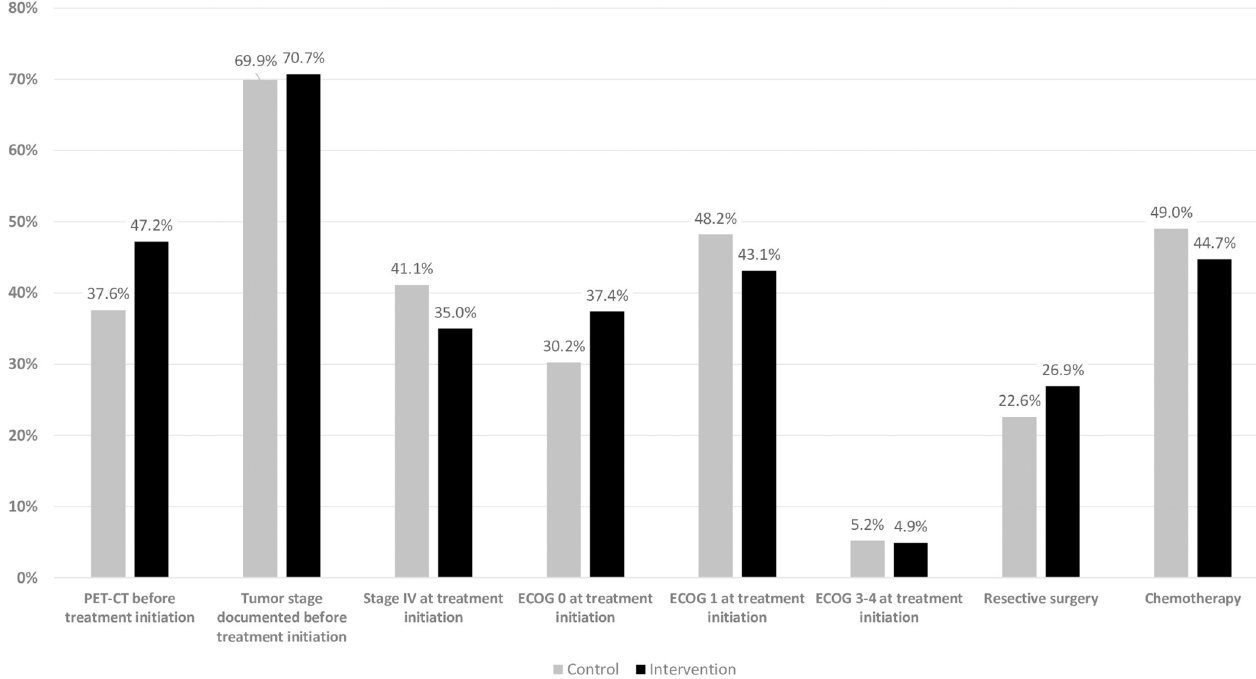
Fig 3. Between-cohort differences in post-baseline predictors of overall survival. The vertical axis indicates proportions of study subjects with the corresponding characteristics in the weighted dataset. For numeric data, please see S4a Table in S1 Table.